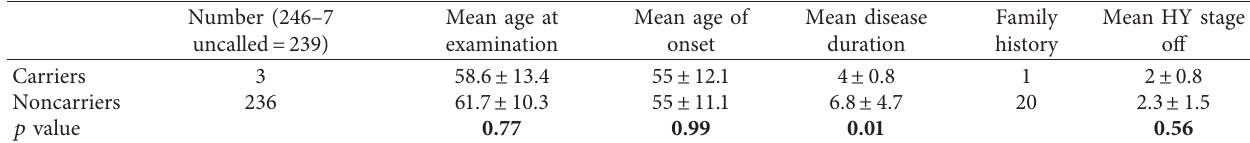
Table 3: p.Gly2385Arg-positive PD patients and their